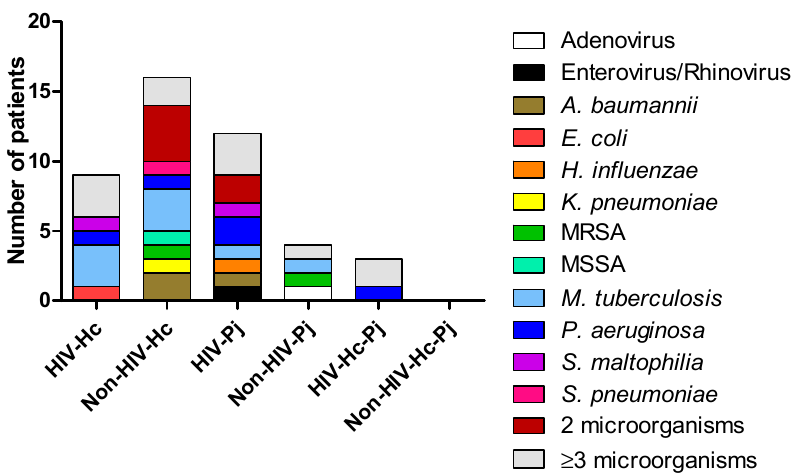
Figure 1. Diagnosis of concomitant infections in the studied patients. Other microorganisms were detected in the BAL samples by different methods: culture for bacteria and other fungi, and PCR for viruses. A. baumannii : Acinetobacter baumannii ; E. coli : Escherichia coli ; H. influenzae : Haemophilus influenzae ; K. pneumoniae : Klebsiella pneumoniae ; MRSA: Methicillin-resistant Staphylococcus aureus ; MSSA: